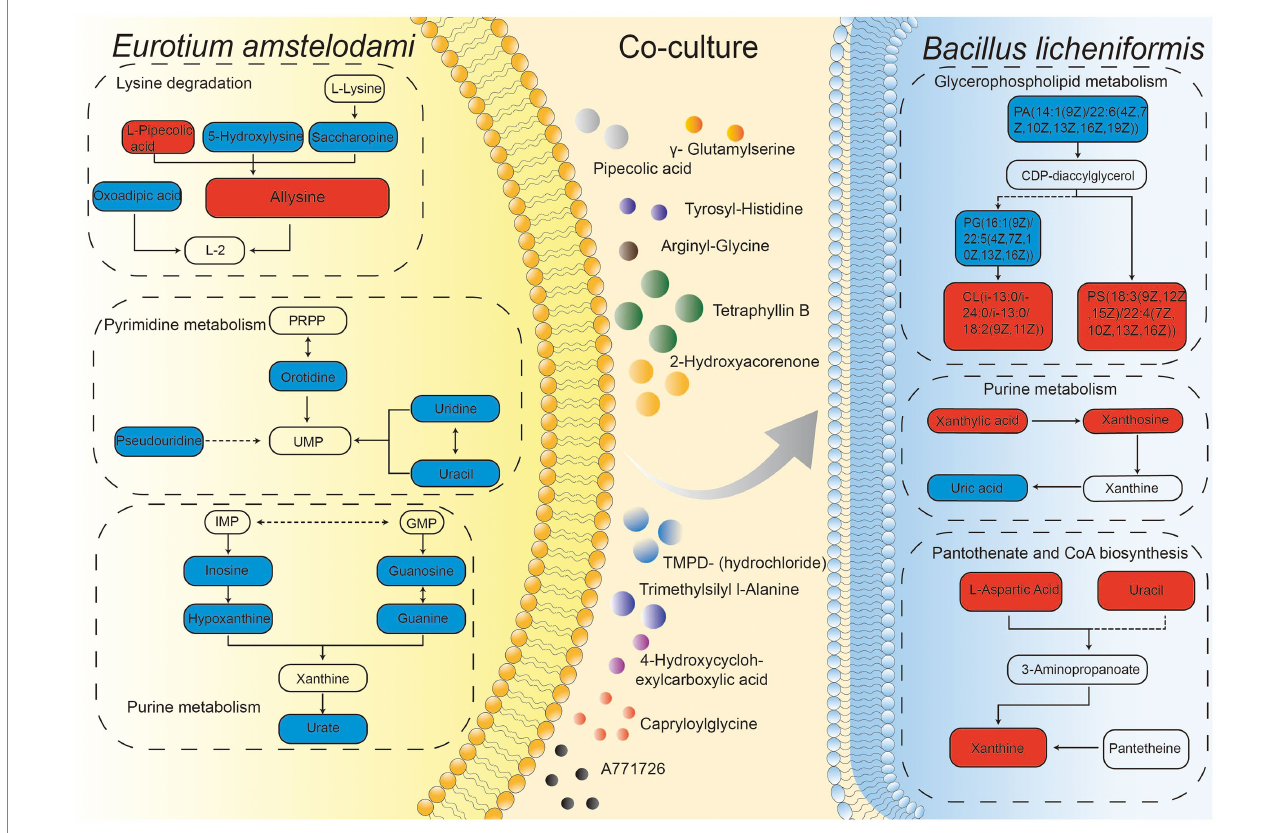
FIGURE 6 Integration map of some metabolic pathways for intracellular and extracellular metabolites of E. amstelodami and B. licheniformis